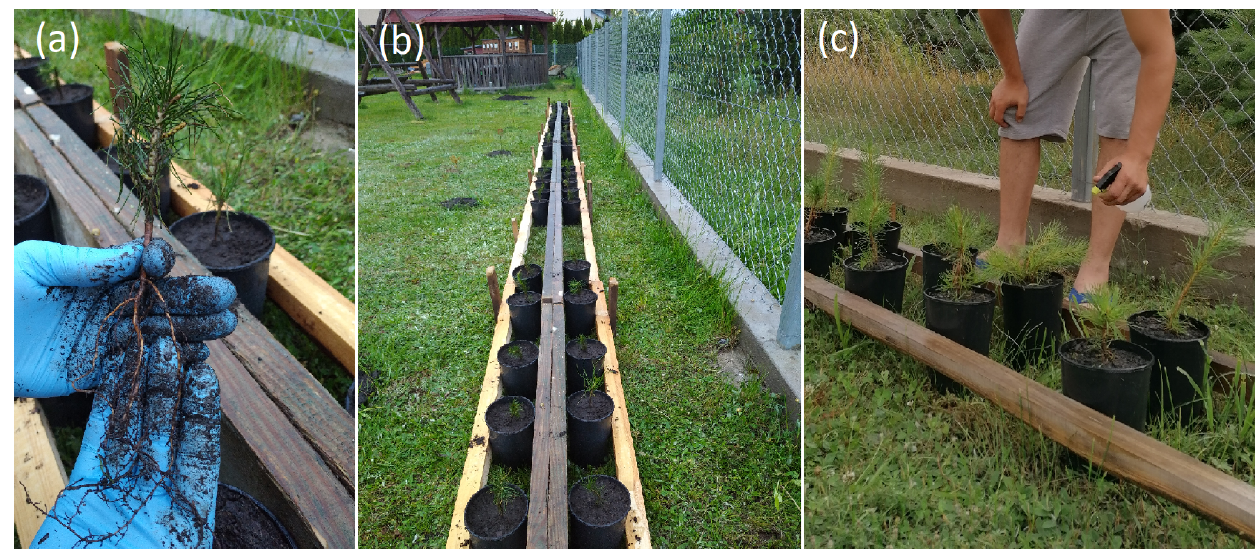
Figure 1. Example of pine seedling before planting ( a ); method of planting and protecting pine seedlings from wind and wildlife ( b ); application of the silicon preparation on the seedlings ( c